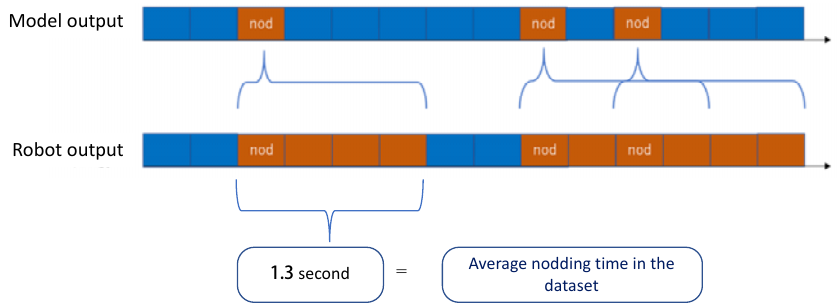
Figure 10. Conceptual diagram of the filtering from the outputs of the nodding model to actual robot